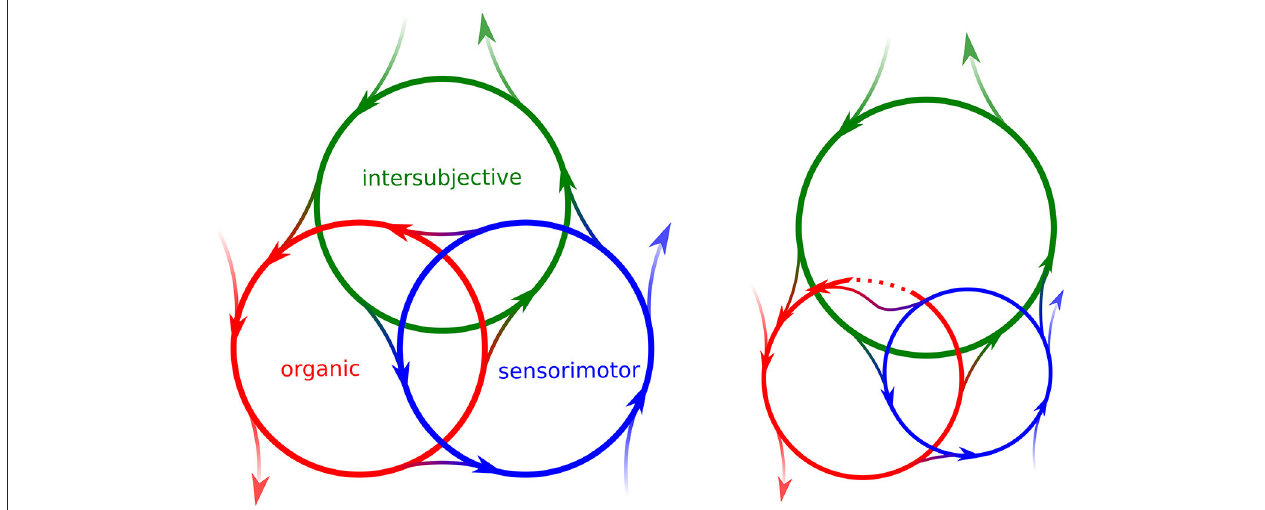
FIGURE 1 | Dimensions of embodiment. Left: the organic (red), sensorimotor (blue), and intersubjective (green) dimensions of embodiment are composed of cycles or loops (circles), interrelated in a non-hierarchical way and deeply influencing each other (arrowed lines between circles). The regulation of each dimension occurs under precarious conditions, that is, in interaction with the environment that can enable, facilitate or constrain internal constitutive processes (lines directed outwards or toward a loop). Right: a disorder in an organic loop (broken red cycle), e.g., arterial disease, can limit sensorimotor capacities (reduced blue circle). A disruption in the organic cycle can begin to be compensated by the sensorimotor dimension (walking therapy), which is supported by the intersubjective loop (interaction with